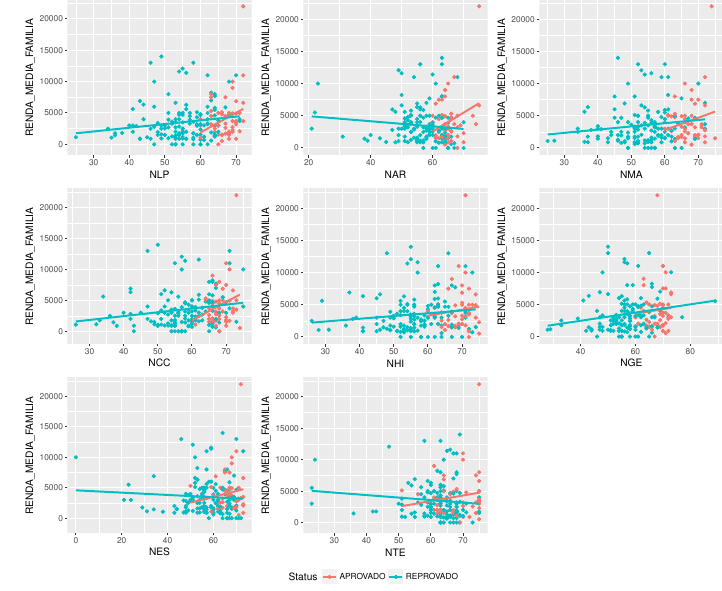
Figure 10. Correlation between discipline’s grade and income.